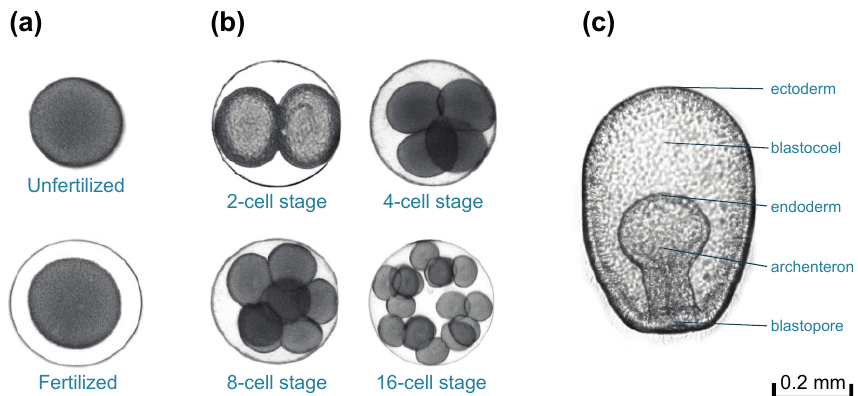
Figure 1. Early life history processes or stages assessed in this study: ( a ) fertilization; ( b ) early cleavage; and ( c ) gastrulation.